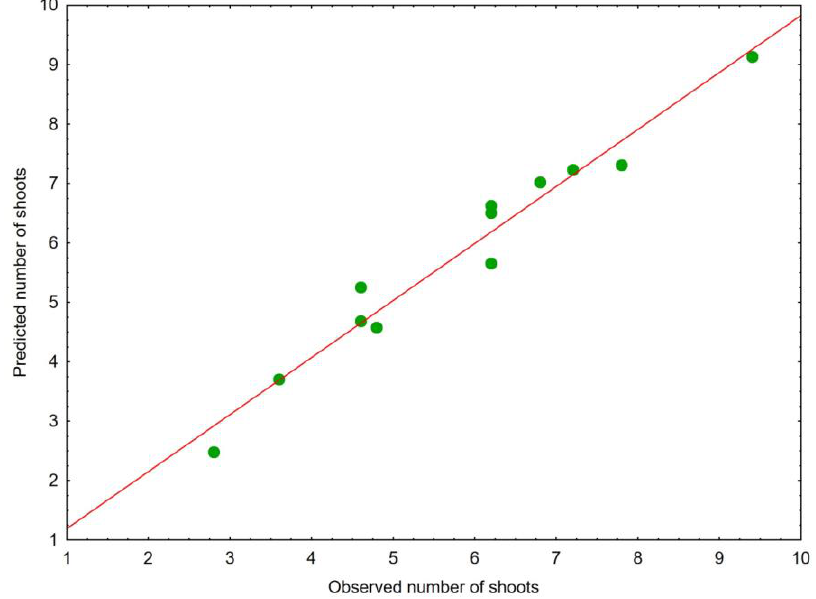
Figure 5. Observed number of shoots of multiplied plantlets versus predicted data generated by the developed regression model.